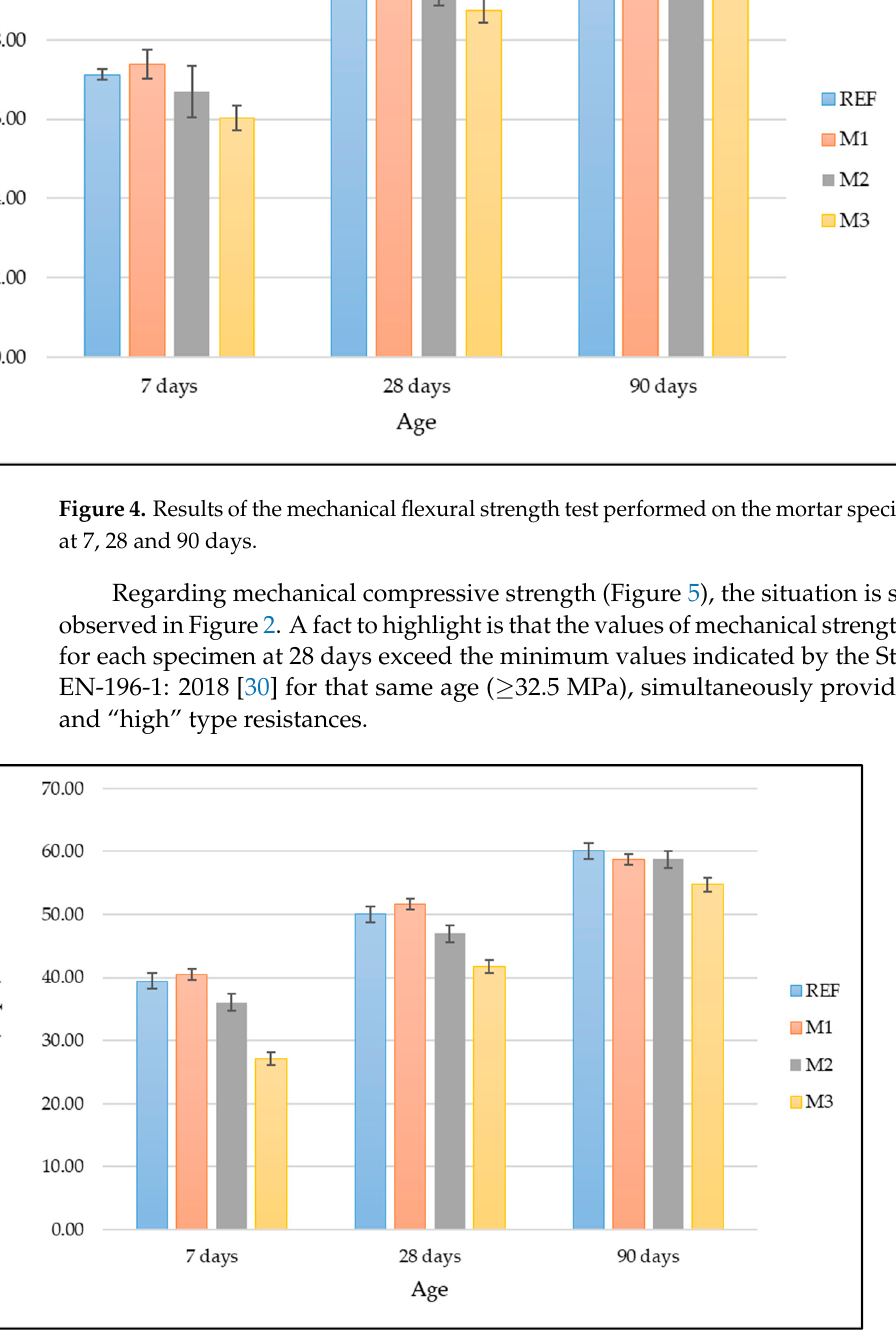
Figure 5. Results of the mechanical compressive strength test performed on the mortar specimens at 7, 28 and 90 days.